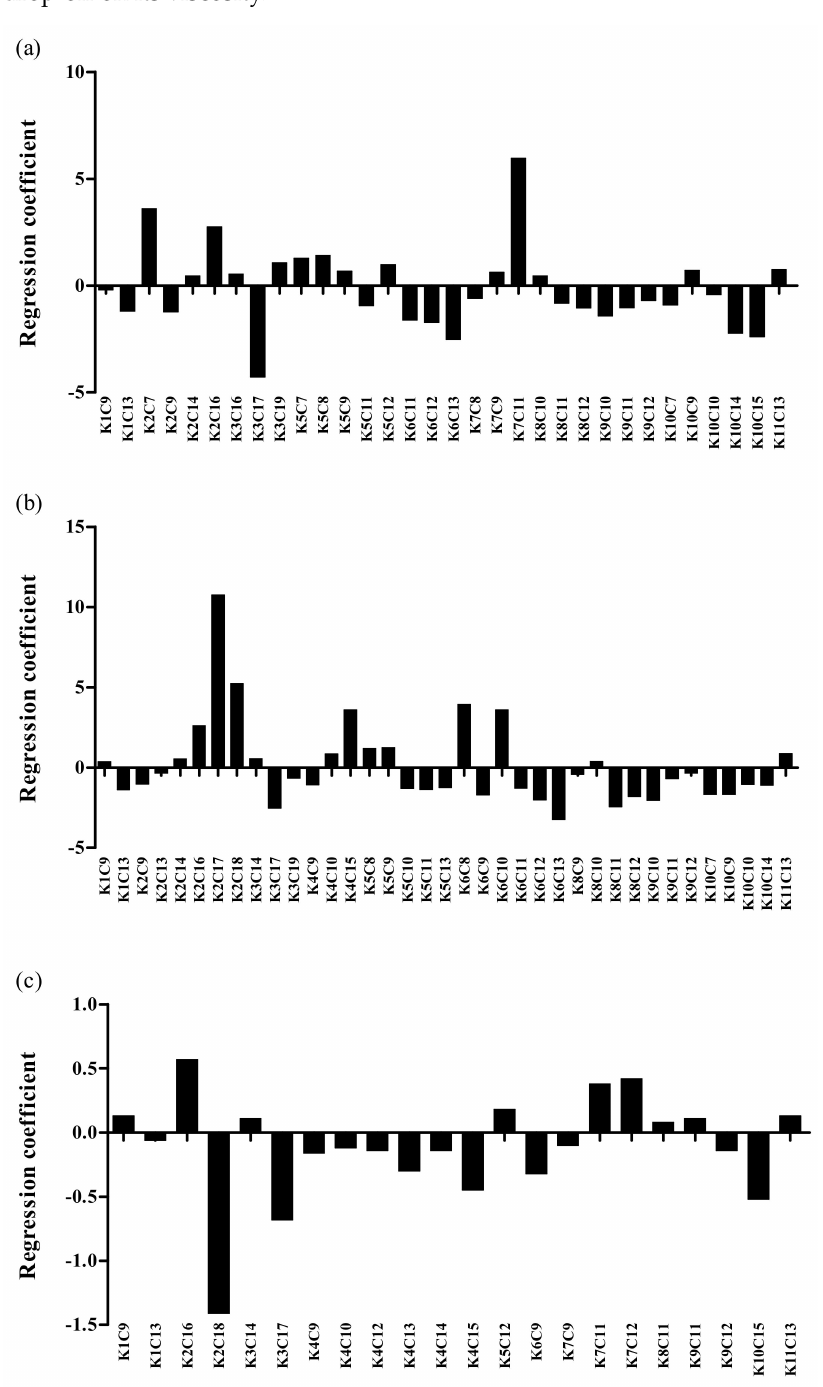
Figure 4. Effect of the hydrocarbon class on fluidity properties: ( a ) freezing point, ( b ) Tco, and ( c ) viscosity at − 20 ◦